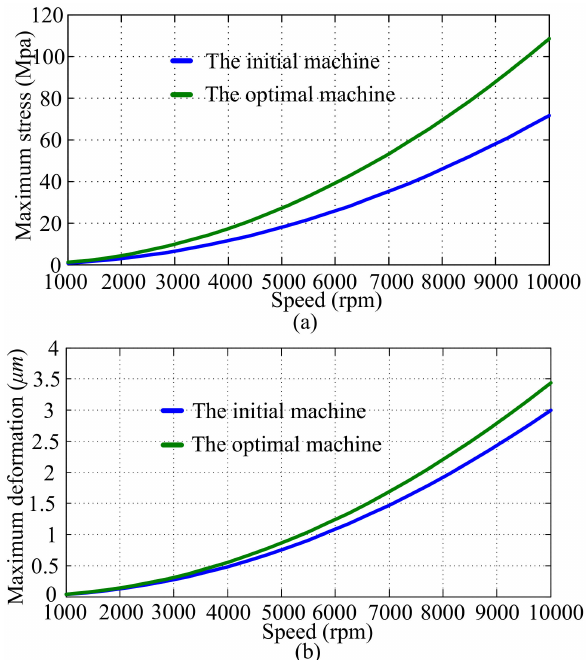
Figure 13. Rotor mechanical performances of the machine before and after optimization: ( a ) maximum stress vs. speed; ( b ) maximum deformation vs.